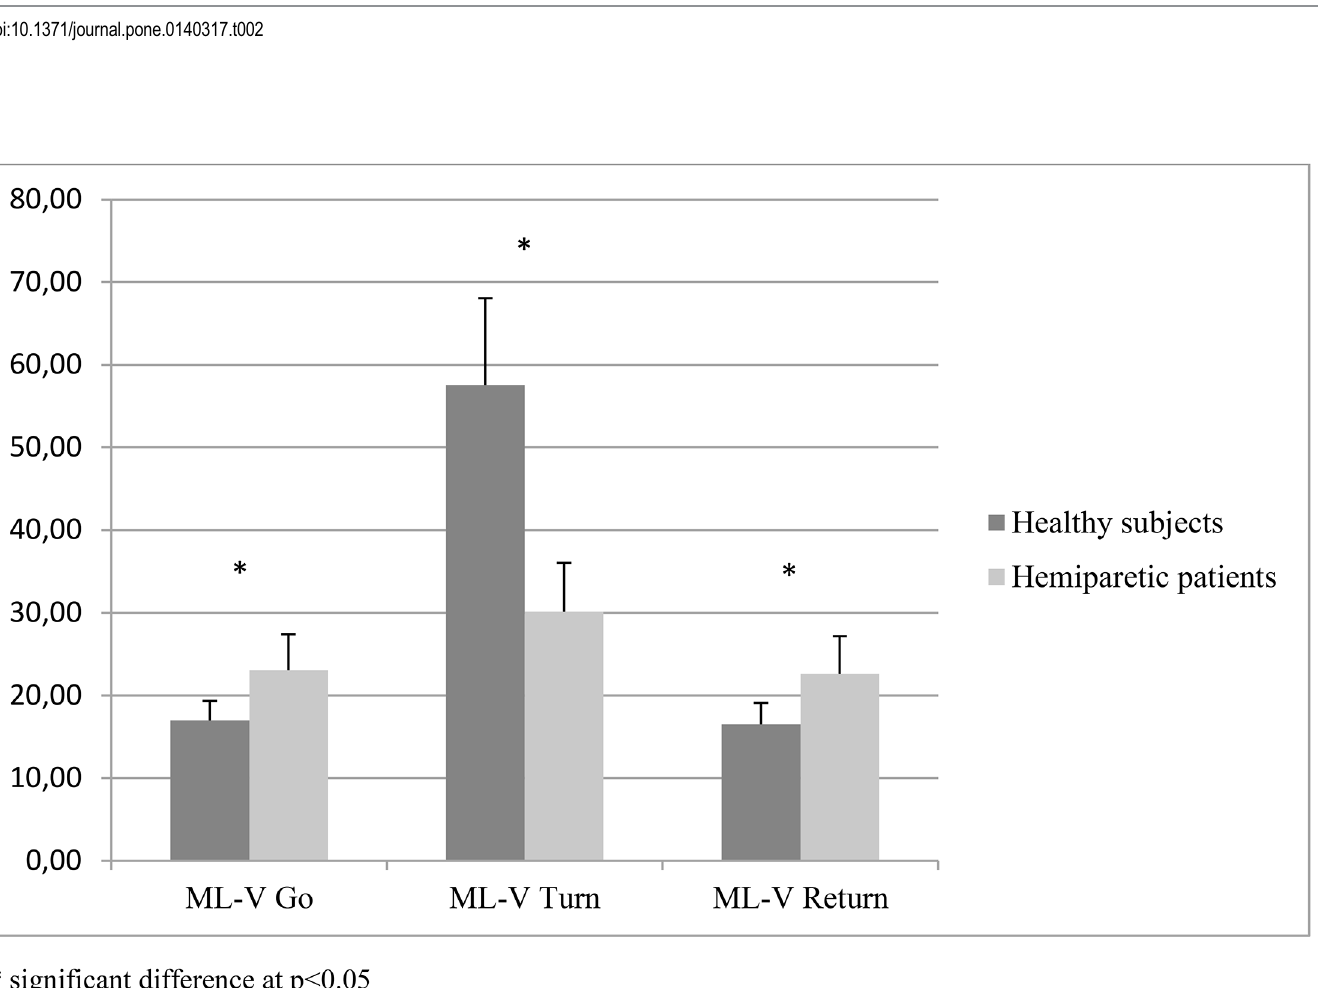
* signi fi cant difference between hemiparetic patients and healthy subjects for the corresponding sub-task of the TUG p < 0,05 † signi fi cant difference between Go, Turn and Return p <